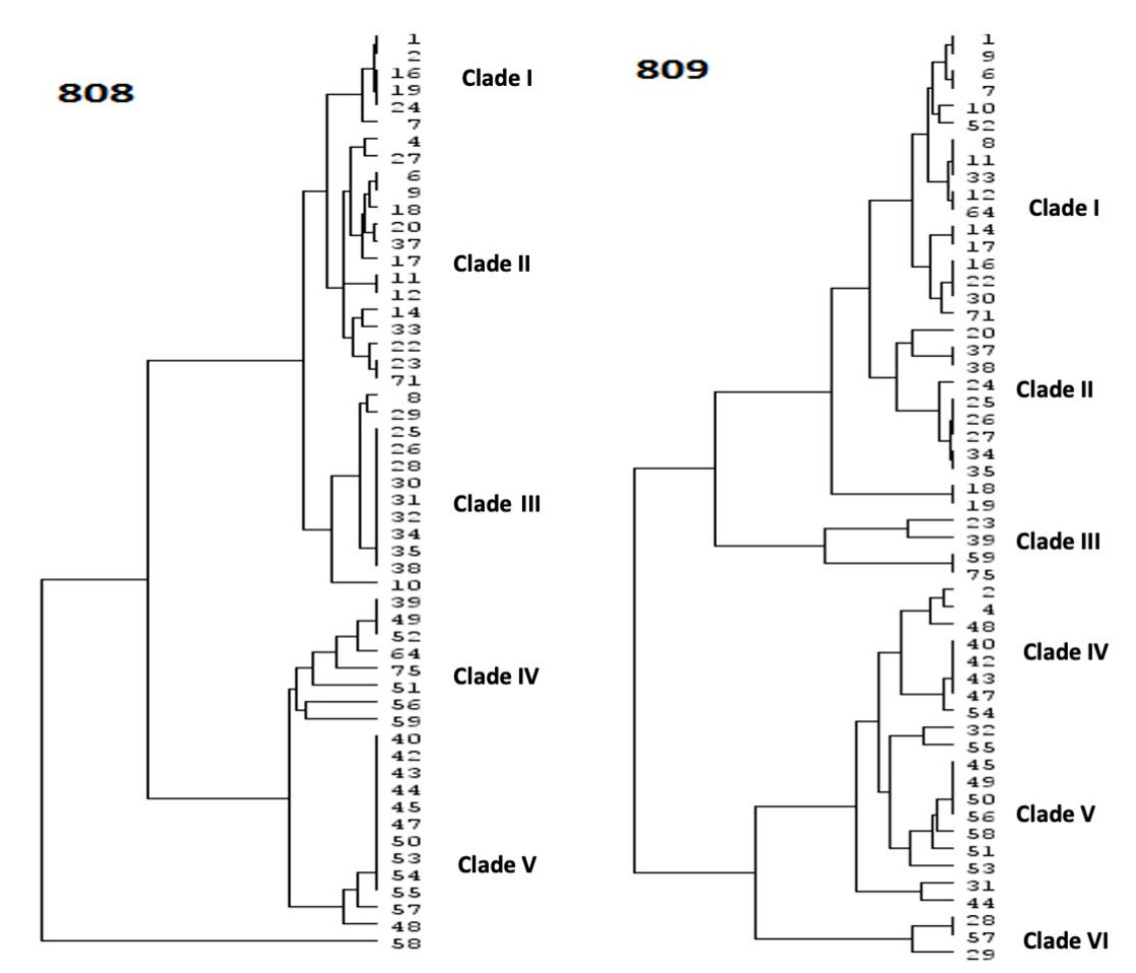
C (808) and (AG) G 8 8